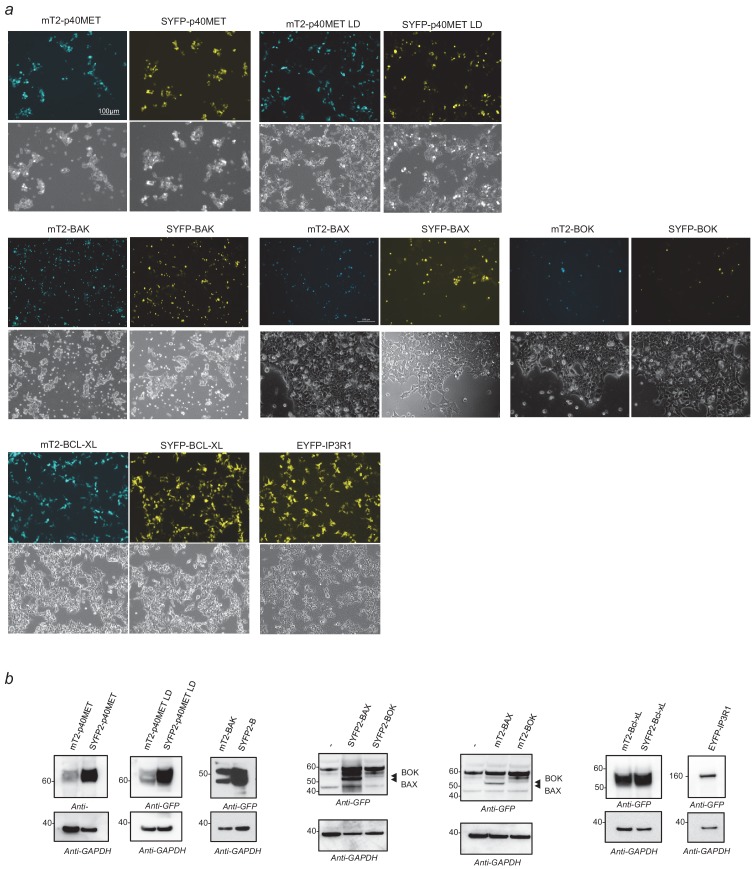
Validation of the vectors expressing m-Turquoise2- or SYFP2-tagged proteins in FRET experiments.(a–b) HEK293 cells were transiently transfected with a vector expressing mTurquoise2- or SYFP2-tagged p40MET, BAK, BAX, BOK, BCL-XL, or EYFP-IP3R1. Twenty-four hours after transfection, cells were (a) analyzed by fluorescence microscopy to check for expression of fluorescent proteins and (b) lysed. Extracts were resolved by 10% SDS-PAGE and analyzed by western blotting with anti-GFP and anti-GAPDH antibodies.